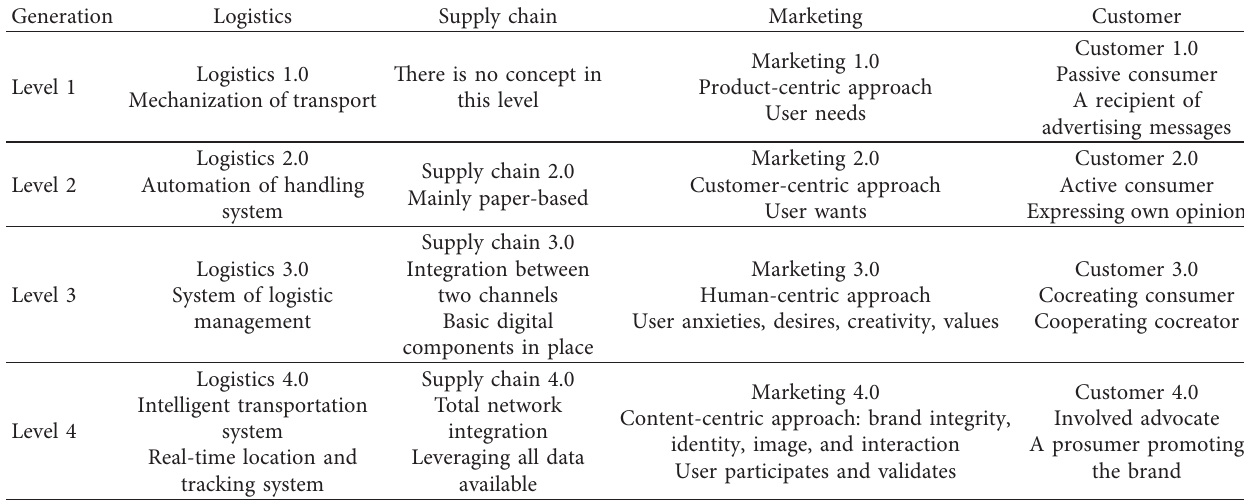
Table 10: The generations of logistics, supply chain, marketing, and customer.